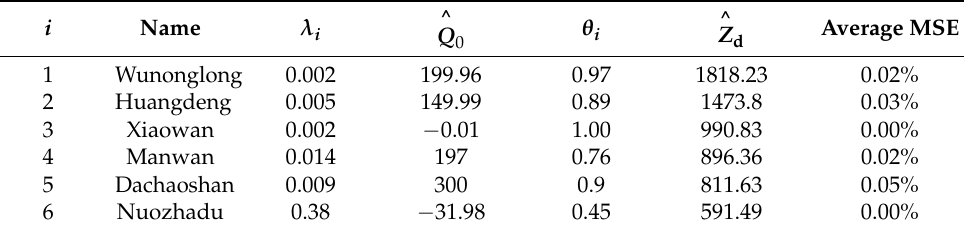
Table 4. Parameters in Z d